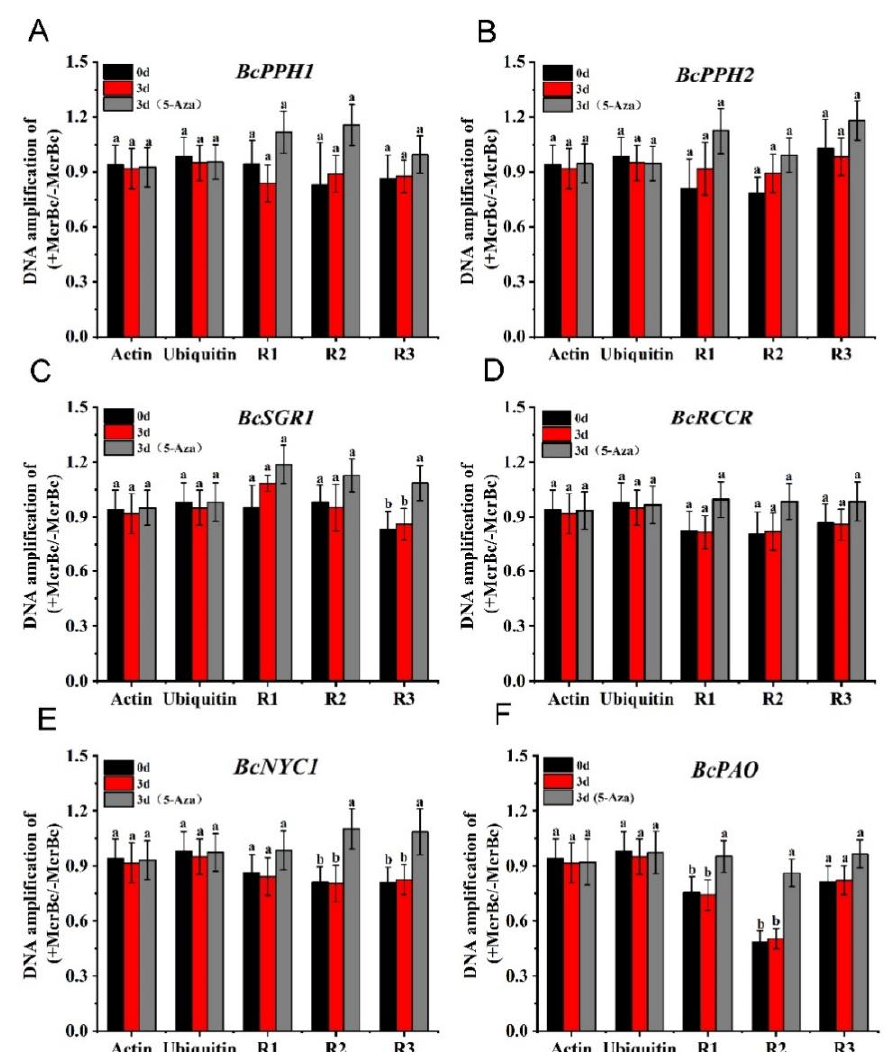
Figure 8. The methylation levels of the chlorophyll degradation genes ( BcPPH1 , BcPPH2 , BcSGR1 , BcRCCR , BcNYC1 , and BcPAO ) in the promoter regions R1, R2, and R3, at 0 d, 3 d, and 3 d (5-Aza) of storage ( A – F ). The data in the figure are the mean ± SD of three biological replicates. Different letters means statistically significant difference in the same same gene region ( p < 0.05).